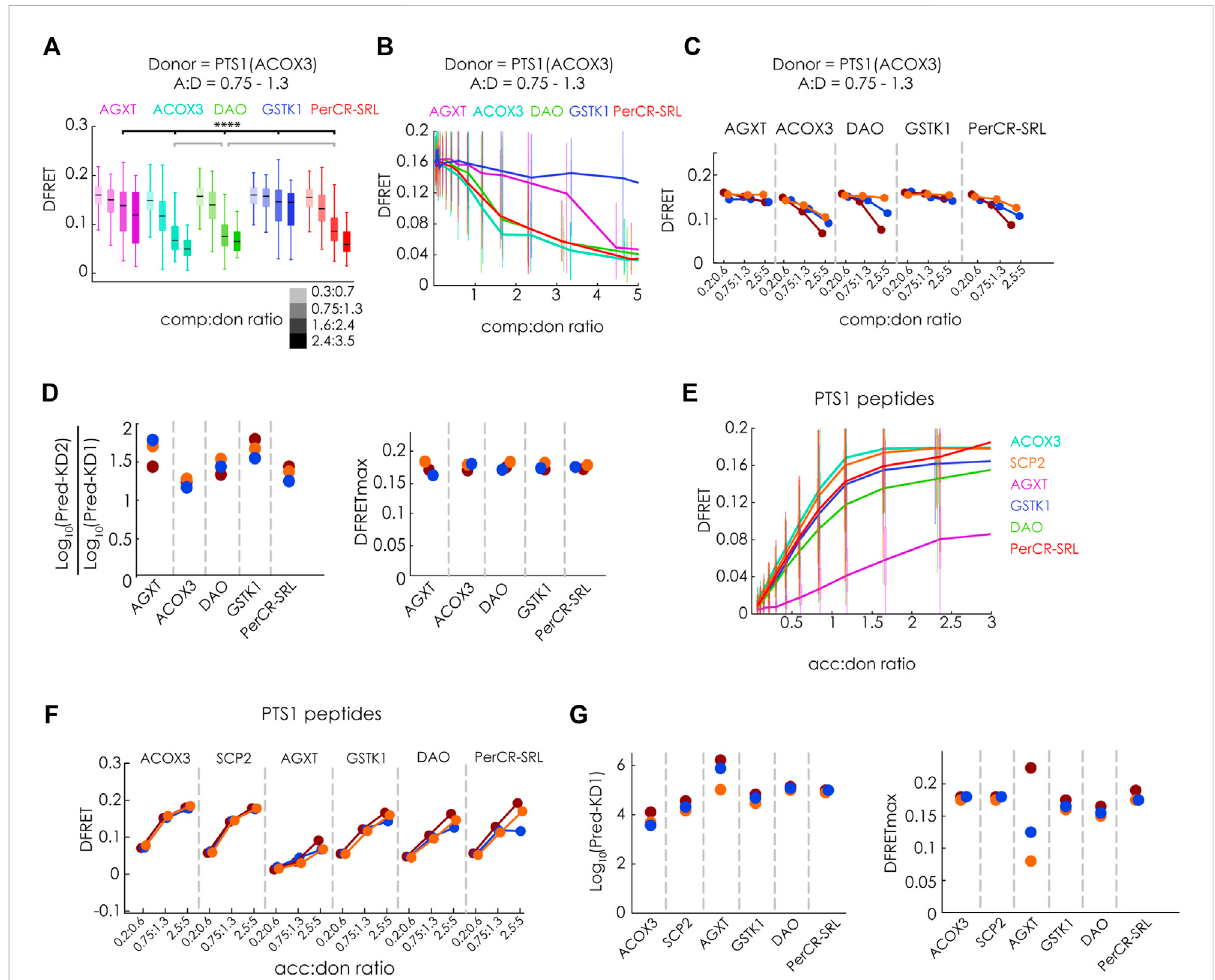
FIGURE 5 Studying the binding of full-length PTS1-carrying proteins to PEX5 by fl owFRET competition experiments: pex5 − / − MEF expressing mCherry- PEX5(TPR)asacceptorandvariousdonorandcompetitormoleculeswereanalyzedby fl owcytometrytoobtainalargenumberofcells (A – D) donor: EGFP-PTS1(ACOX3), competitor: Cerulean-tagged full length proteins of hAGXT, hACOX3, hDAO, hGSTK1, pig PerCR; (A) the median DFRET values of subpopulations sharing an acc:don ratio of 0,75 < x < 1,3 and different competitor to donor ratios or (B) the DFRET decay curves (increasing comp:don)ofcellssharinganacc:donratioof0,75 < x < 1,3aredepicted( cf .Figures3A,B); (C) thepatternofthedecaycurvesiscomparablebetween three different experiments and (D) the results of the fi tting (Pred.-KD1, Pred.-KD2 and DFRETmax) are plotted as ratio of Log 10 (Pred.-KD2)/Log 10 (Pred.-KD1) or as DFRETmax; (E – G) donor: EGFP-PTS1 variants harboring the PTS1 of hAGXT, hACOX3, hDAO, hGSTK1, pig PerCR; (E) DFRET saturationcurves(increasingacc:don); (F) whencomparingsubpopulationssharingthesameacc:donratiothepatterniscomparablebetweenthree different experiments and (G) results of the fi tting algorithm (Pred.-KD1, and DFRETmax) are plotted as Log 10 (Pred.-KD1) (left side) and DFRETmax (right side). Statistics: (A) box blots with quartiles and ranges, multicomparison “ Tukey-Kramer ” for cells sharing acc:don rations between 0,75 < x < 1,3 and comp:don ratios between 1,6 < x < 2,4, predictions (D) and (G) were analyzed by a bootstrapping method (details of the statistics cf. Supplementary Table